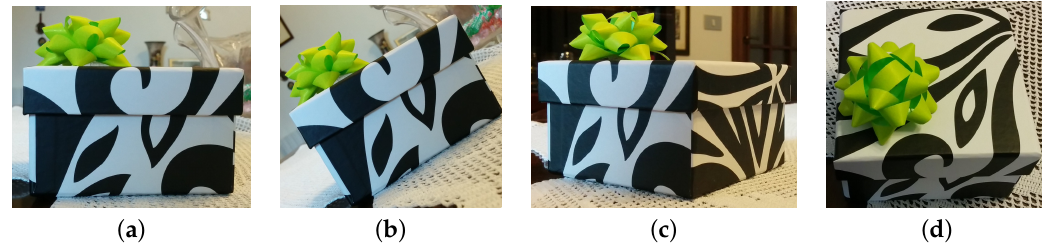
Figure 1. Examples of image views obtained by rotating the camera along three (approximately) orthogonal axes. ( a ) original camera pose; ( b ) rotating along the optical axis of the original camera pose; ( c ) rotating the camera towards the right of the object; and ( d ) rotating the camera towards the top of the